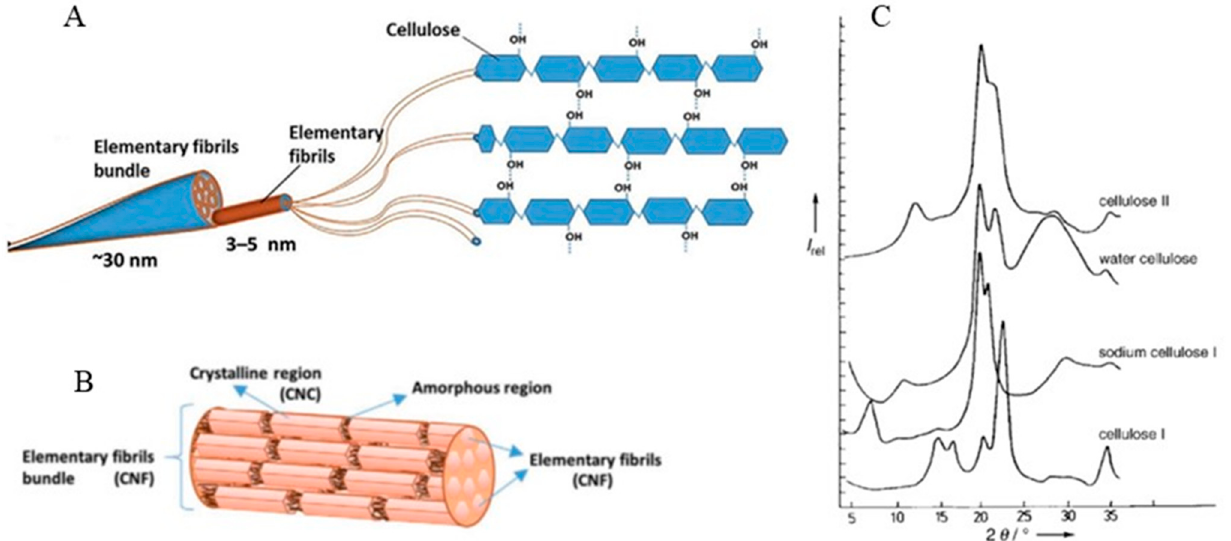
Figure 2. ( A ) Hierarchical cellulose fibrils. ( B ) Schematic of a cellulose bundle showing the organi- zation of crystalline and amorphous regions (Reproduced with permission from authors [21]. ( C ) X-ray wide angle scattering of cellulose crystallinity phase transformation (Reproduced with permission from authors [21,22].